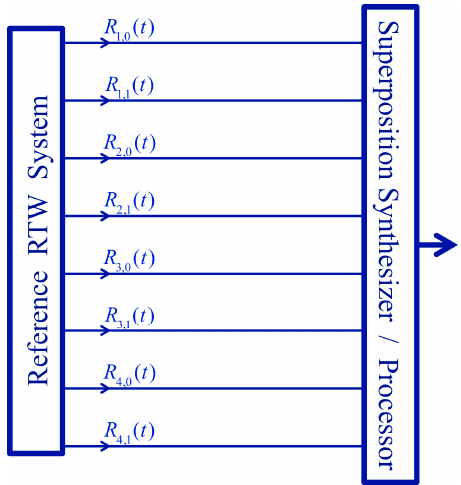
Figure 2. Generic hardware schematics to form a superposition from the reference signals.